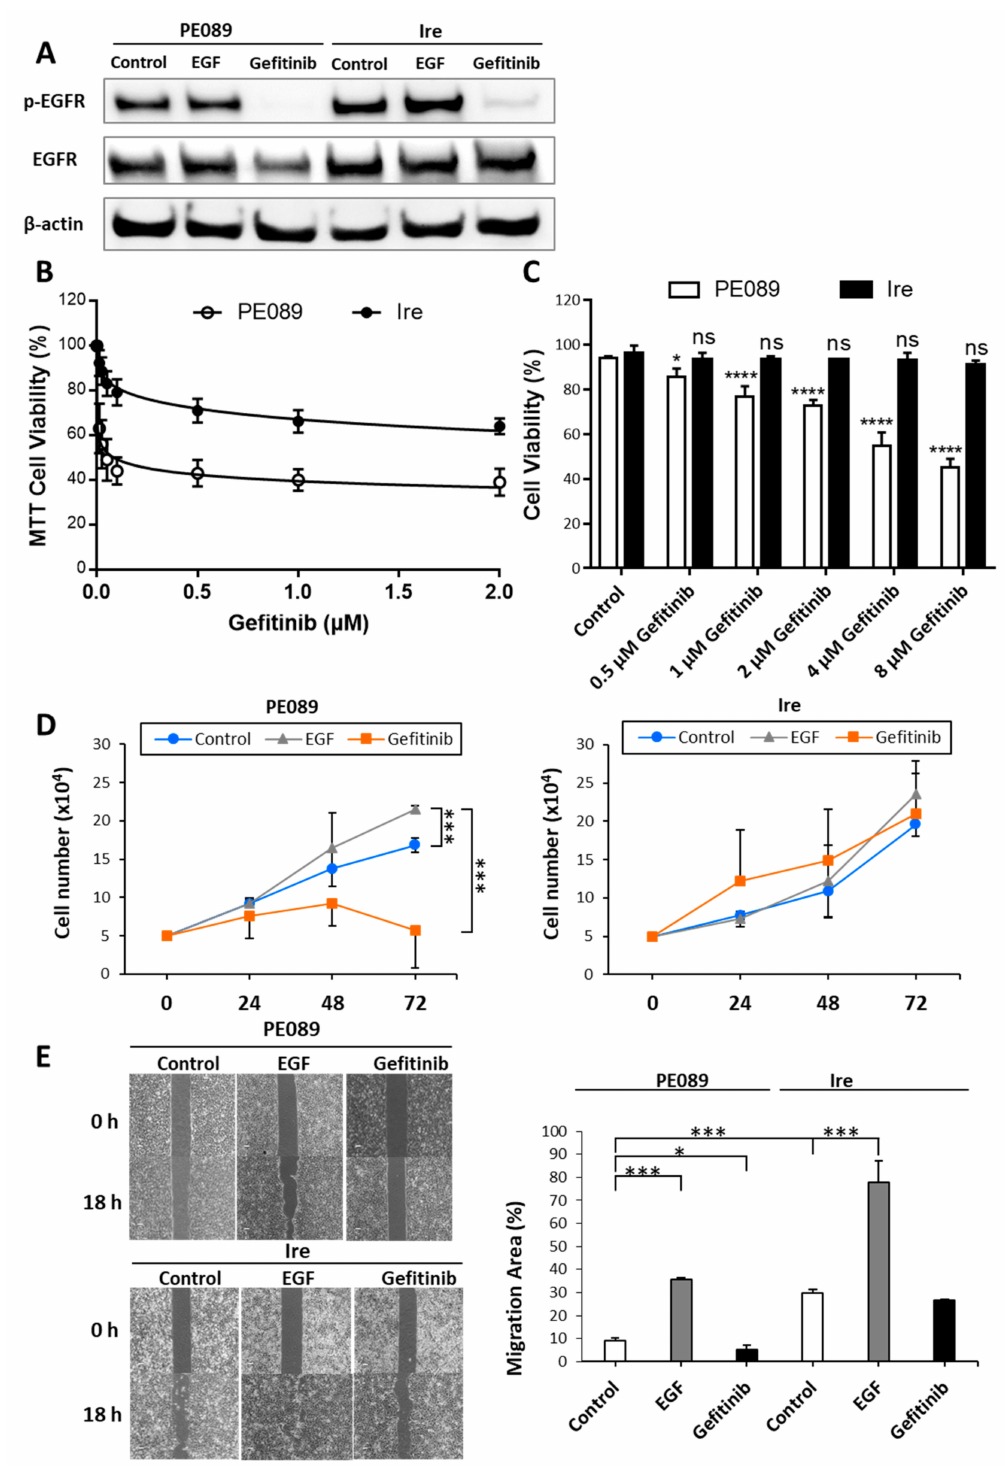
Figure 1. Ire cells are resistant to gefitinib. ( A ) Representative immunoblots of phosphorylated-epidermal growth factor receptor (p-EGFR), EGFR and β -actin are shown. PE089 cells and Ire cells were treated with or without 100 ng / mL EGF and 1 µ M gefitinib for 24 h. Decreased p-EGFR levels were observed in gefitinib-treated PE089 cells. ( B ) 3-(4,5-Dimethylthiazol-2-yl)-2,5-diphenyltetrazolium bromide (MTT) assays for PE089 and Ire